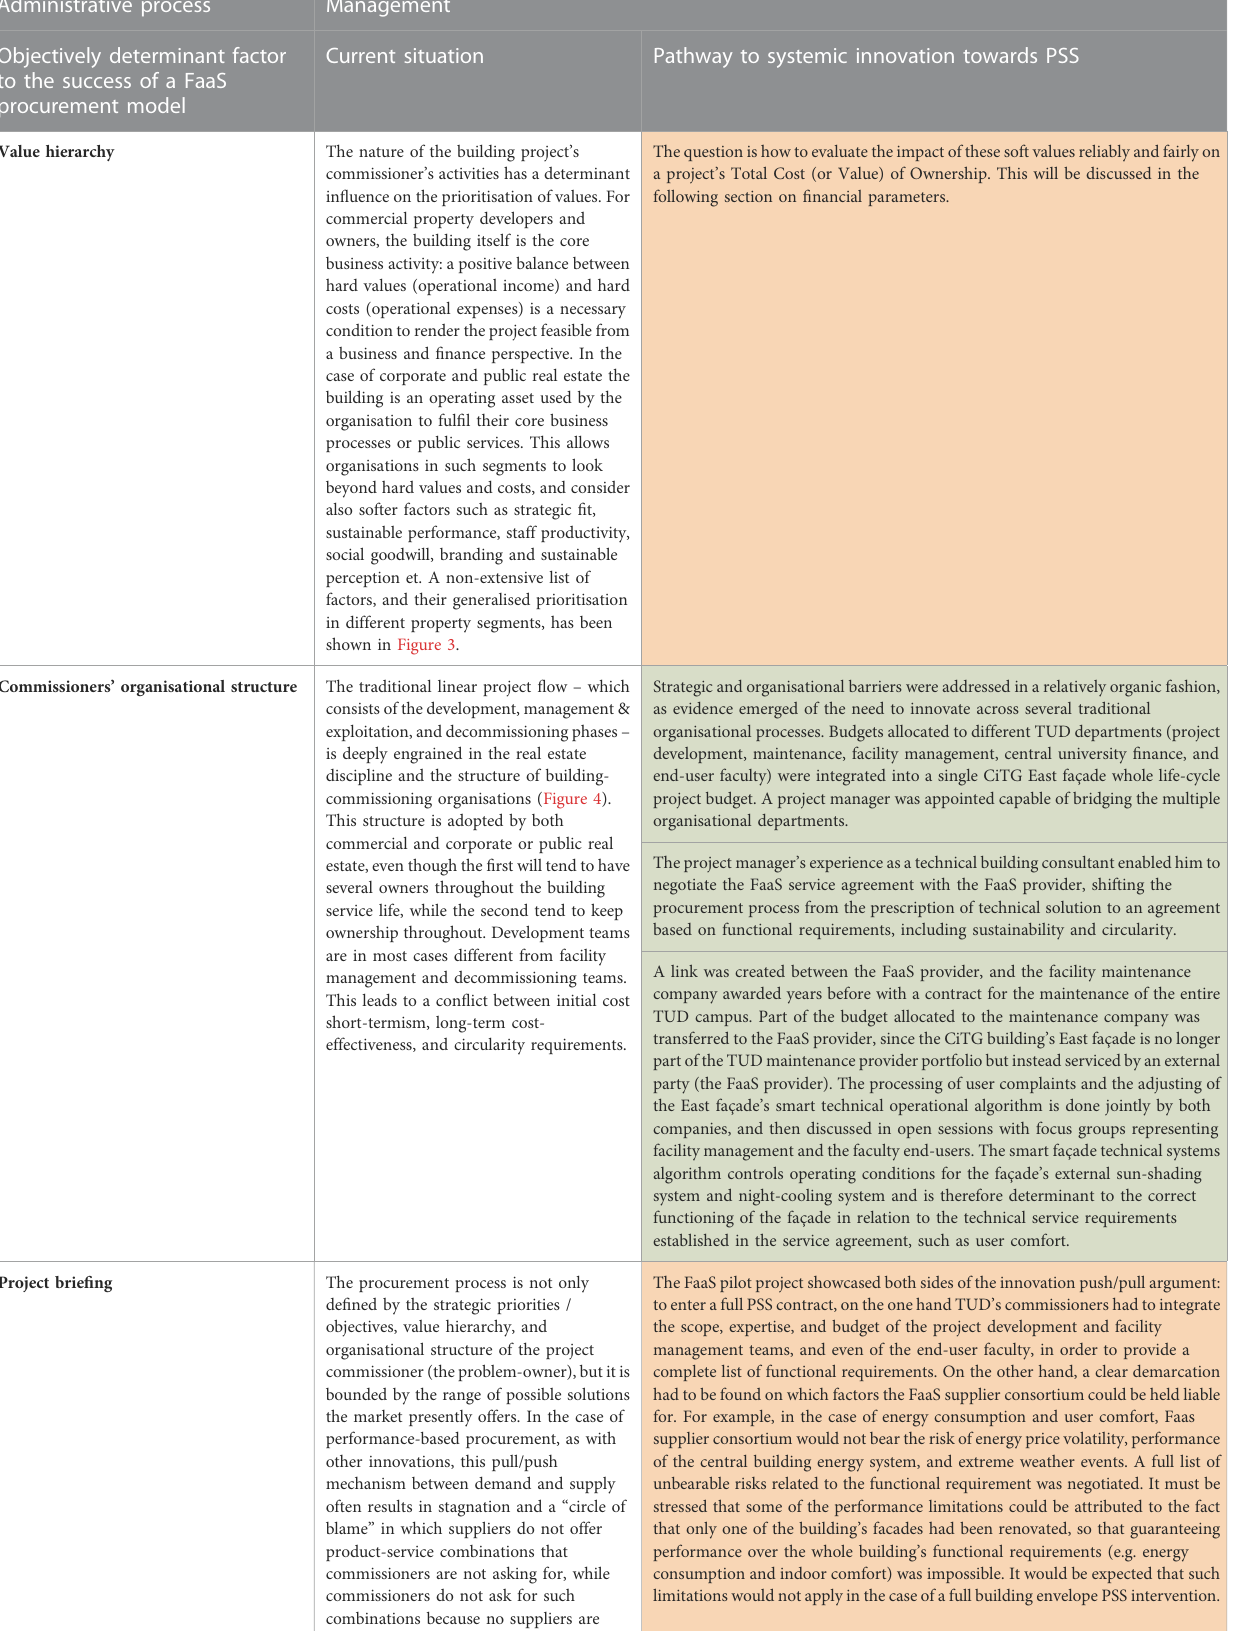
TABLE 4 Systemic innovation pathways required for each determinant factor towards PSS for building